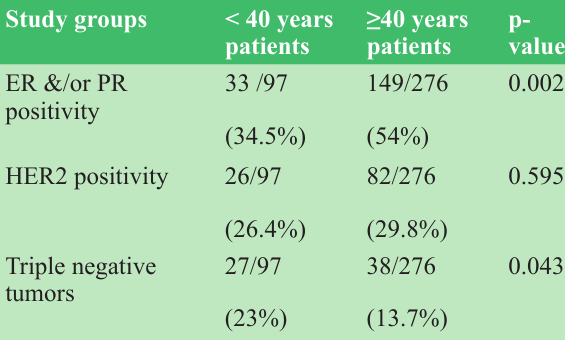
Table 2: Comparison of ER PR HER 2 neu expression between two groups Study